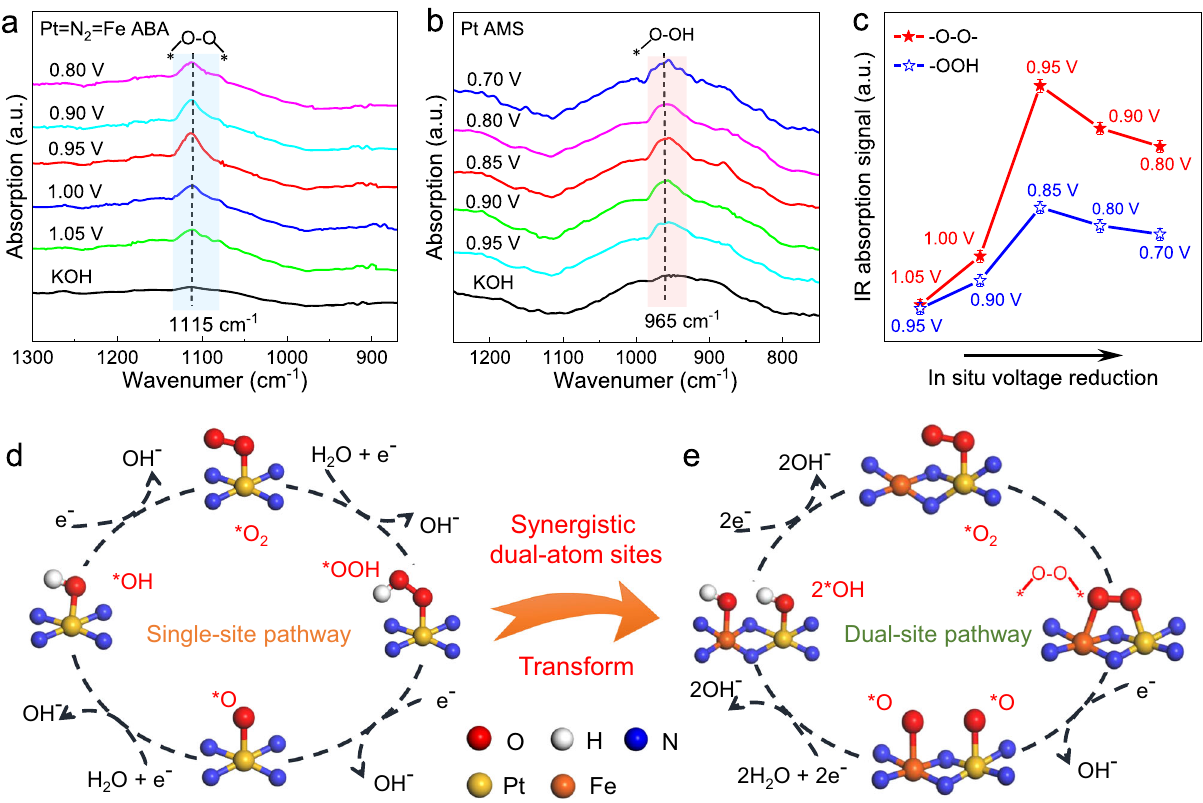
c FTIR absorption stretching at 1115cm − 1 for Pt=N 2 =FeABA and at965cm − 1 for Pt AMS. d , e SchematicoftheORRmechanismforPt=N 2 =FeABA( e )andPtAMS( d